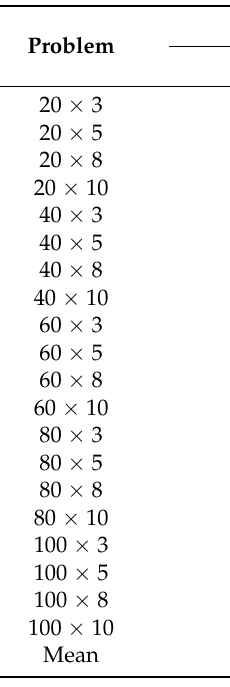
Table 11. IGD -metric for SDABC and IMDABC.